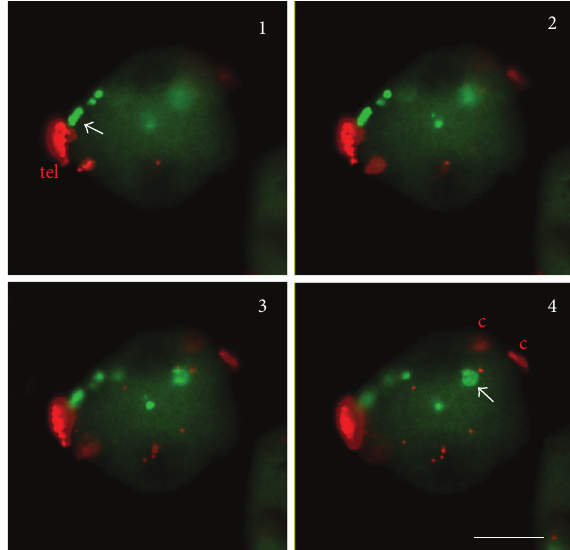
F 5: Topological arrangement of the telomere cluster (tel), rye centromeres (c), and the subtelomeric heterochromatin chromo- mere (arrows) of the short arm of chromosome pair 5R added to wheat in a 3D section stack. Only one of the 5RS telomeres entered the bouquet the other is in the middle of the nucleus close to the heterochromatic chromomere. Bar represents 10 𝜇𝜇